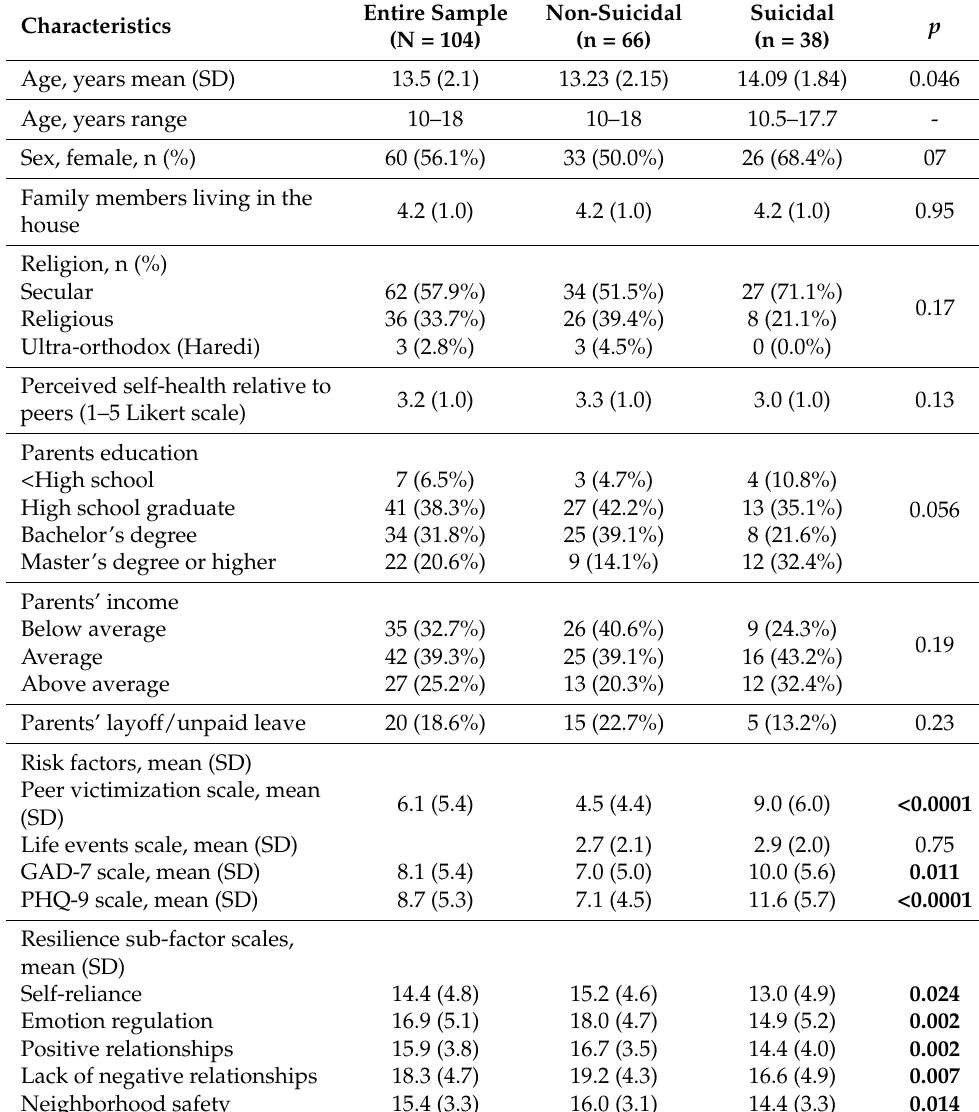
Table 1. Sociodemographic and clinical characteristics of the study